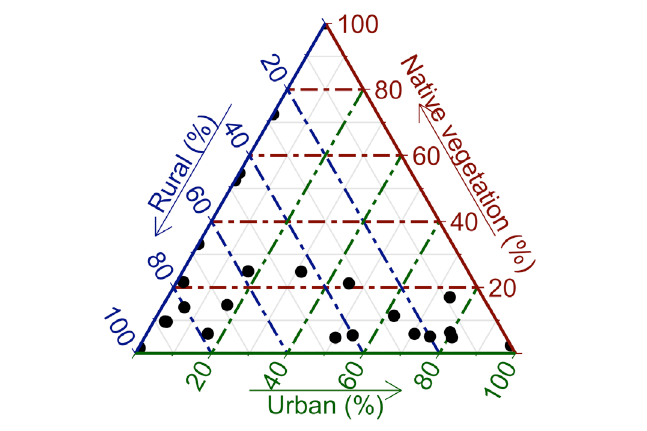
FIGURE 2 | Ternary diagram of land use/occupation in the 24 streams sampled in the state of Paraná,